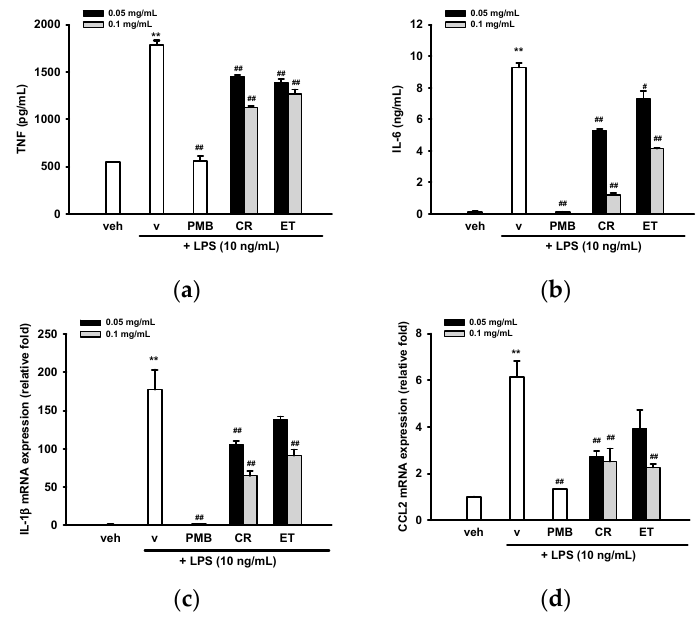
Figure 4. Effects of ethanol extracts of C. rutidosperma and E. thymifolia on the production and expression of pro-inflammatory cytokines in LPS-treated BV2 cells. ( a , b ) BV2 cells were treated with indicated reagent for 16 h and the supernatant were collected for TNF and IL-6 assay, as described in Materials and Methods; ( c , d ) BV2 cells were cultured with indicated reagent in six-well plates for 4 h followed by RNA extraction and RT-Q-PCR, as described in Materials and Methods. Data are represented as the mean ± SD ( n = 3). Statistical differences are presented ** p < 0.01 compared with the vehicle control (without LPS) and # p < 0.05; ## p < 0.01 compared with the LPS-treated vehicle.